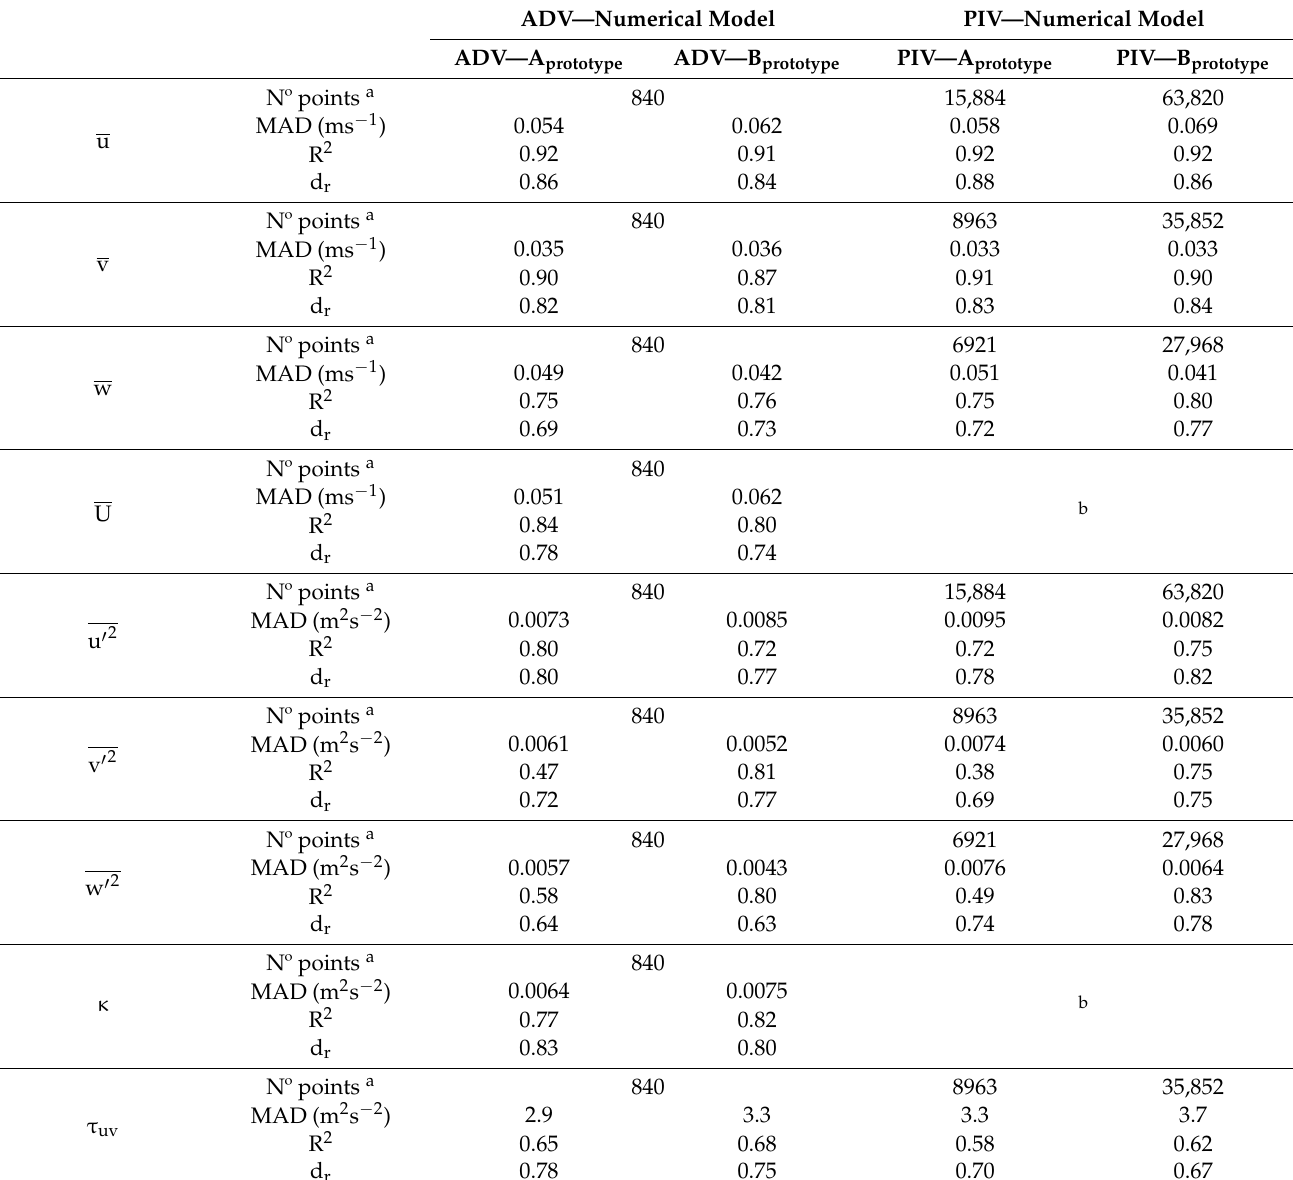
Table 4. Comparison between numerical model results at prototype scale and measurements. ADV—Numerical Model PIV—Numerical